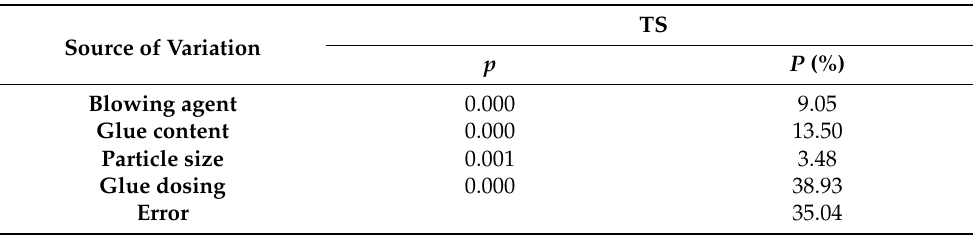
Table 3. ANOVA for selected factors affecting TS of manufactured particleboards ( p —probability of non-significant effects, P —percentage